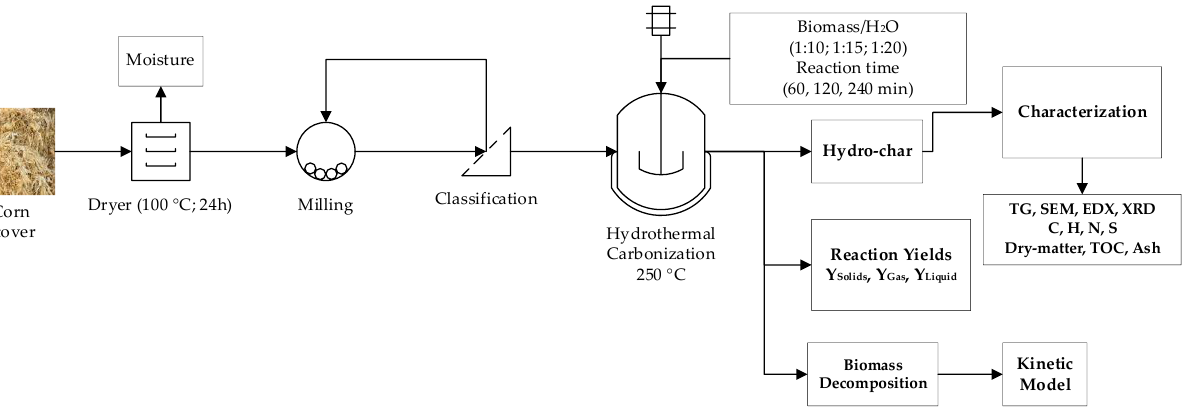
Figure 1. Process flow diagram of the hydrothermal processing of corn stover with hot-compressed H 2 O in pilot scale.